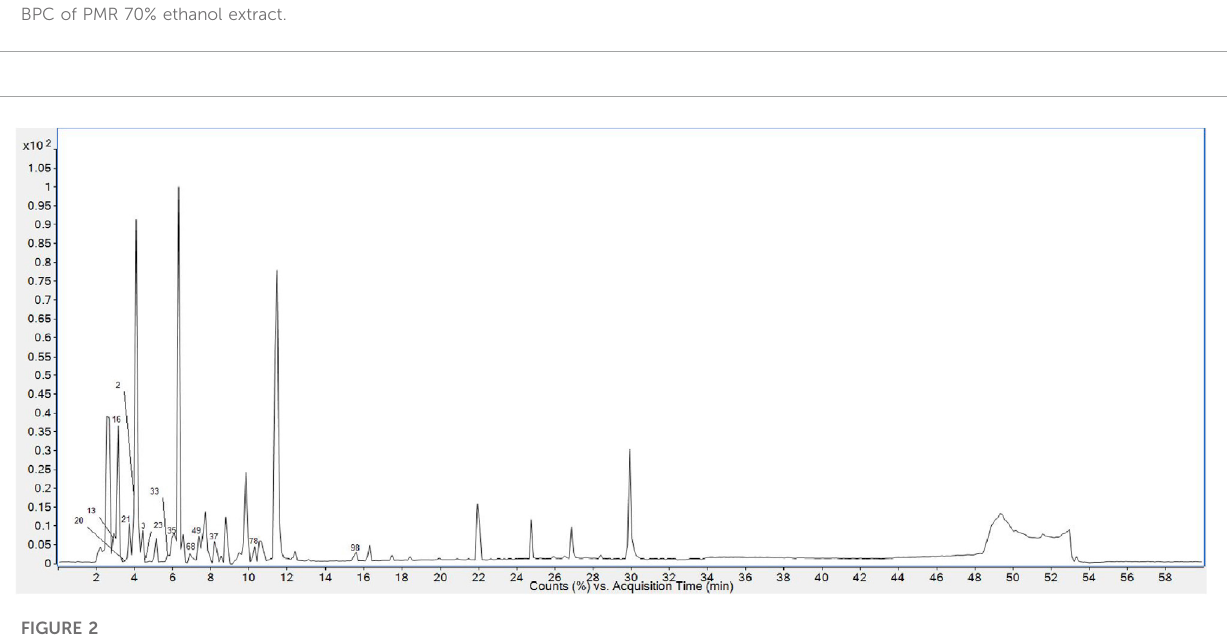
FIGURE 2 BPC of PMR water